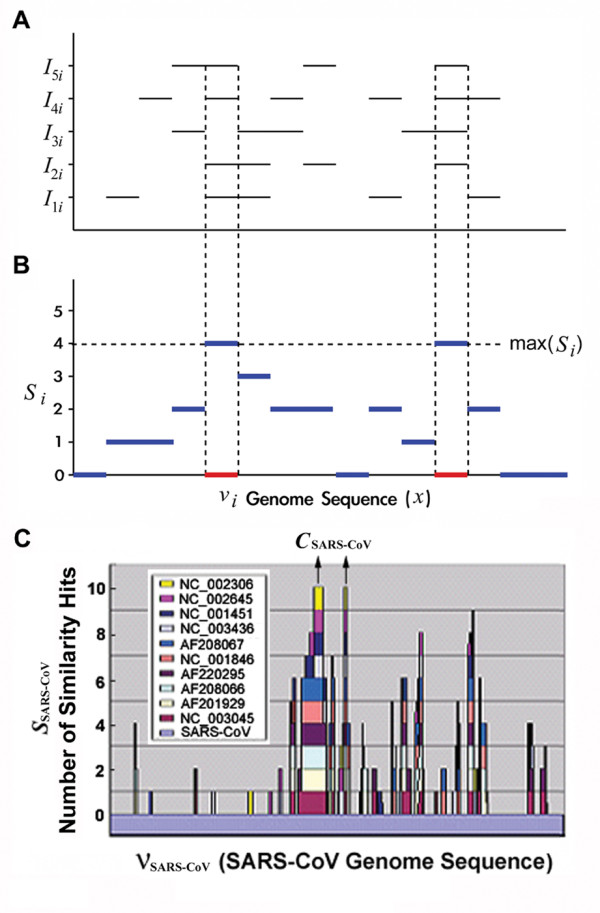
Algorithm for designing conserved probes. Schematic illustration of the conserved sequence design method. (A) The similarity sequence segments (I1i to I5i) of a given virus vi are aligned with the sequence segments of the other five viruses within the same viral genus by the BLASTN program to find the regions with high similarity hits. (B) Graph of the numbers of similarity hits, Si, obtained by the procedure illustrated in panel A. The largest number of hits as illustrated is max(Si), which equals 4. The two regions with the highest similarity hits are marked by vertical dotted lines. (C) A case study of locating the conserved sequence segments in coronavirus genus. The genus contains the following 11 fully sequenced viral genomes: NC_002645, human coronavirus 229E; NC_001451, avian infectious bronchitis virus; NC_003436, porcine epidemic diarrhea virus; AF201929, murine hepatitis virus strain 2; AF208067, murine hepatitis virus strain ML-10; AF208066, murine hepatitis virus strain Penn 97-1; NC_001846, murine hepatitis virus strain A59; NC_003045, bovine coronavirus; AF220295, bovine coronavirus strain Quebec; NC_002306, transmissible gastroenteritis virus; and SARS-CoV, SARS coronavirus.